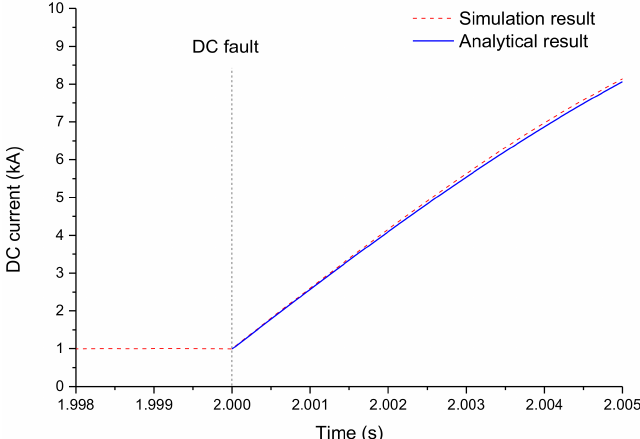
Figure 10. DC current of MMC before